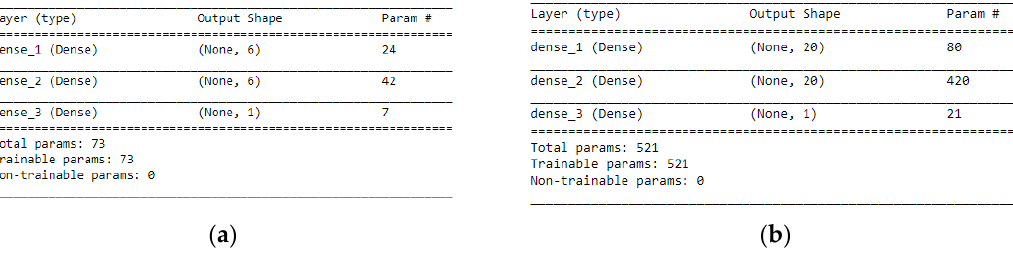
Figure 8. ( a ) The Architectural Structure of the ANN model (3-6-6-1) with 73 trainable parameters; ( b ) The Architectural Structure of the ANN model (3-20-20-1) with 521 trainable